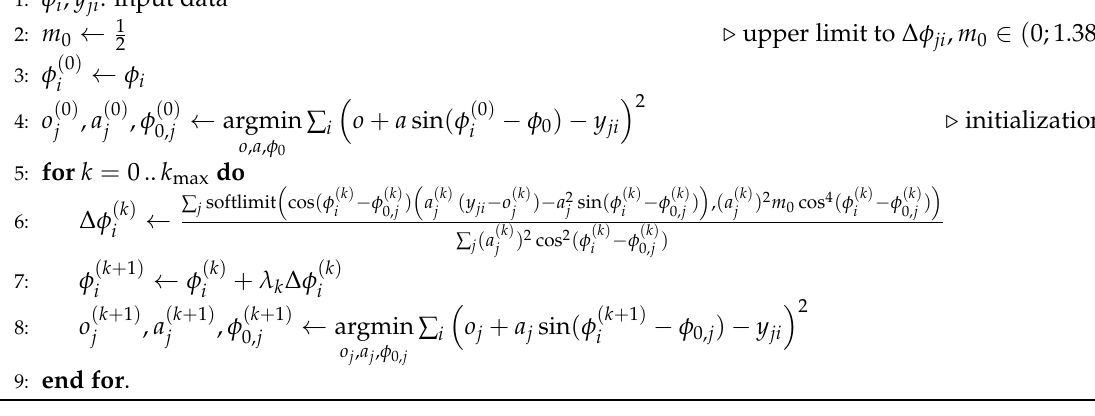
( k ) is desired. For the i